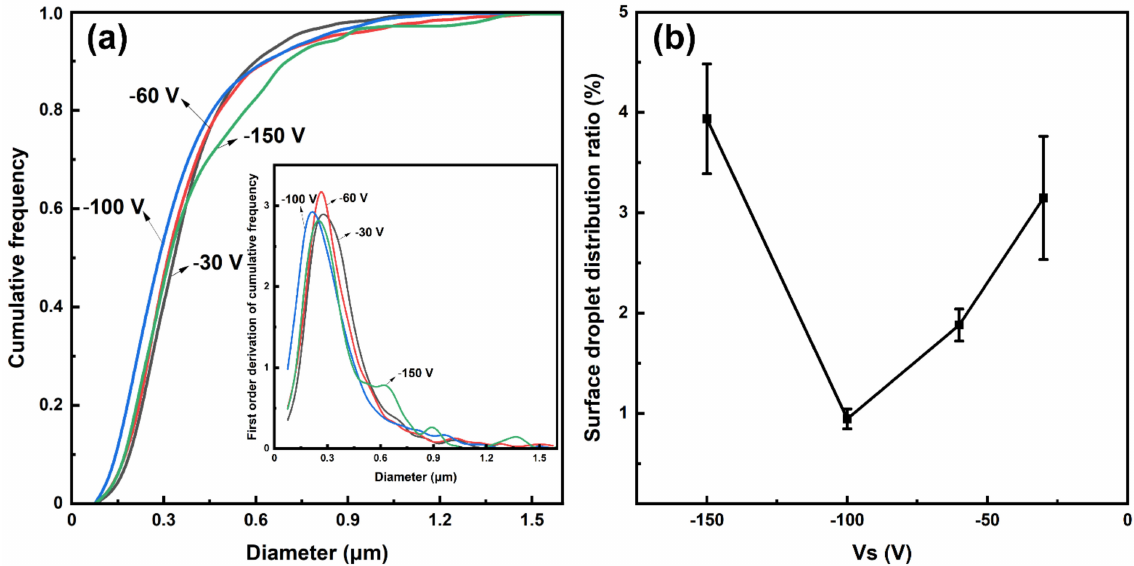
Figure 5. ( a ) The cumulative particle size distribution curve, and ( b ) the droplet distribution area on the surface of the